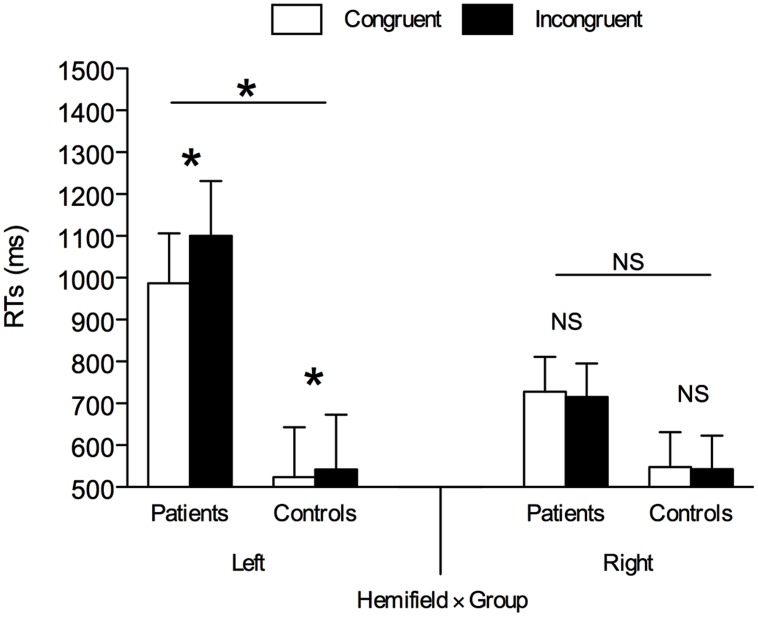
Mean RTs in left and right hemifield in right hemisphere-damaged patients vs. healthy controls. Asterisks denote p < 0.05. NS, Non-Significant; Error bars are SEM.